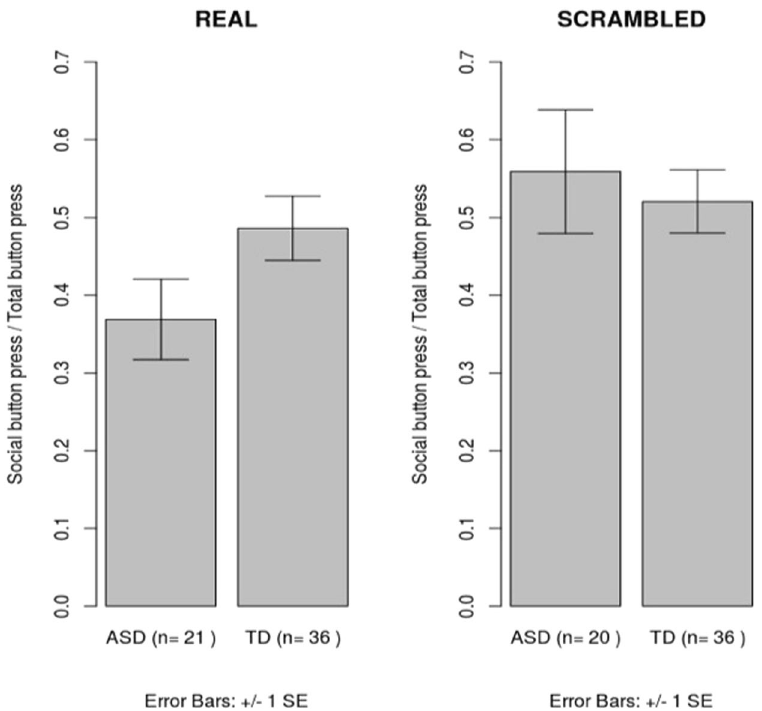
Figure 2. Group difference in relative preference for social stimuli for the real and scrambled image trials